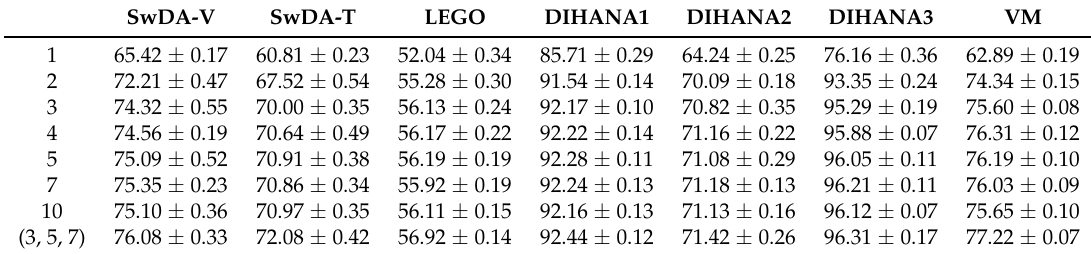
Table 7. Accuracy (%) results obtained using different character windows. The last row refers to the combination of windows that led to the best results in our experiments. The remaining rows refer to the performance of individual windows.